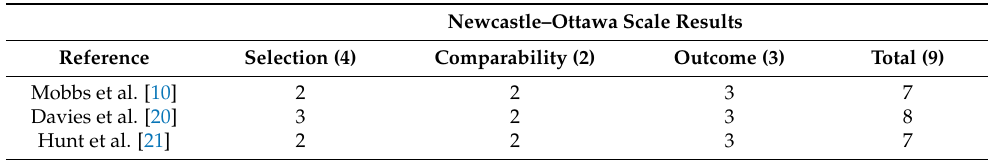
Table 6. Quality assessment using the Newcastle–Ottawa scale (NOS) of the included studies identified from the systematic search. Green = high quality; yellow = moderate